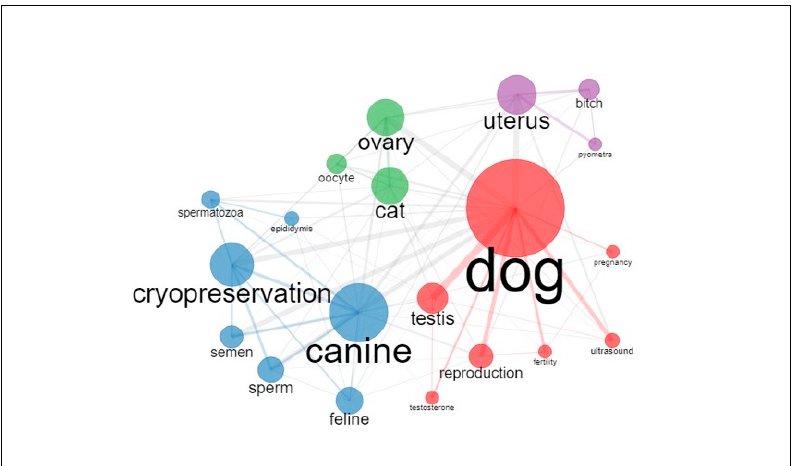
Table 4. Authors’ keywords (AKW) grouped according to controlled vocabulary (MeSH) and their frequencies. Frequencies of Keyword plus (KP) are also reported.